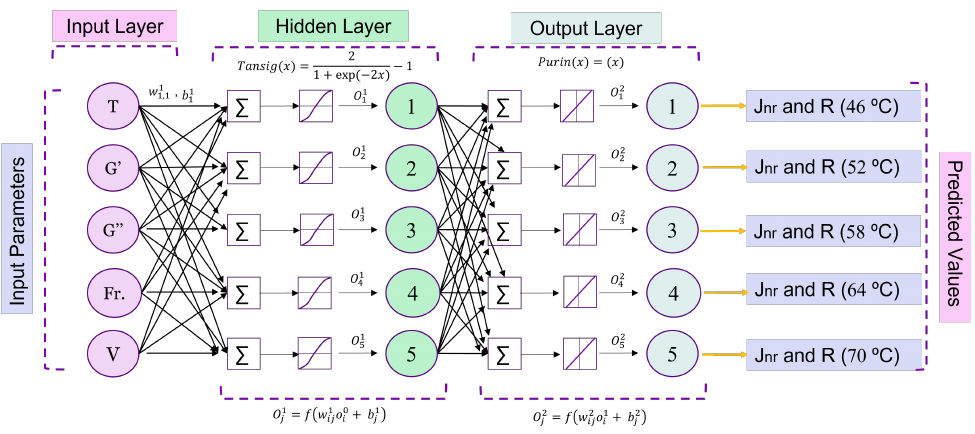
Figure 3. ANN model for predicting recovery and non-recovery performance of asphalt